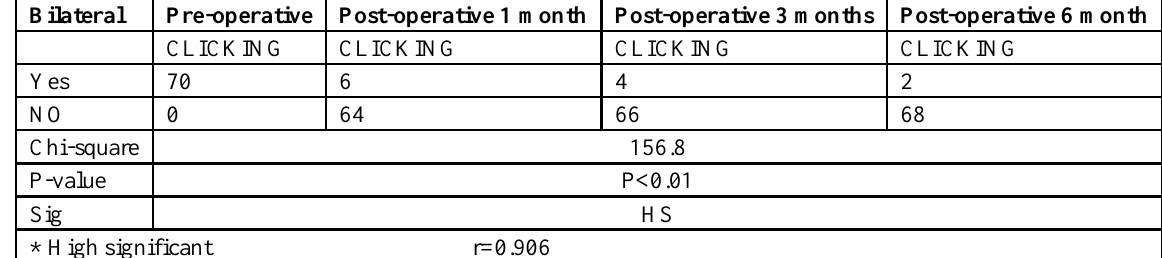
Table 3: Joint Clicking